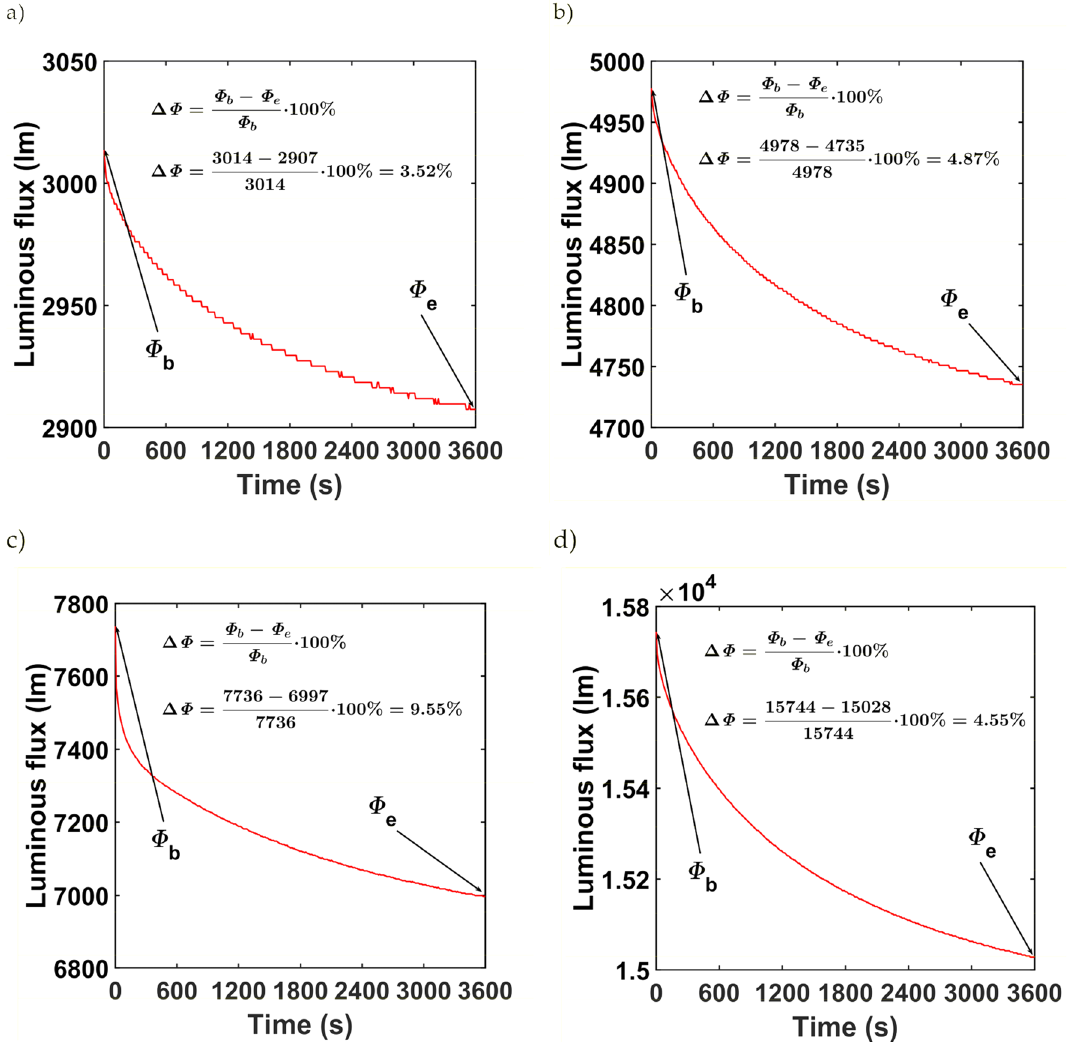
Figure 2. Short-term luminous flux depreciation of ( a ) L1 luminaire, ( b ) L2 luminaire, ( c ) L3 luminaire, ( d ) L4